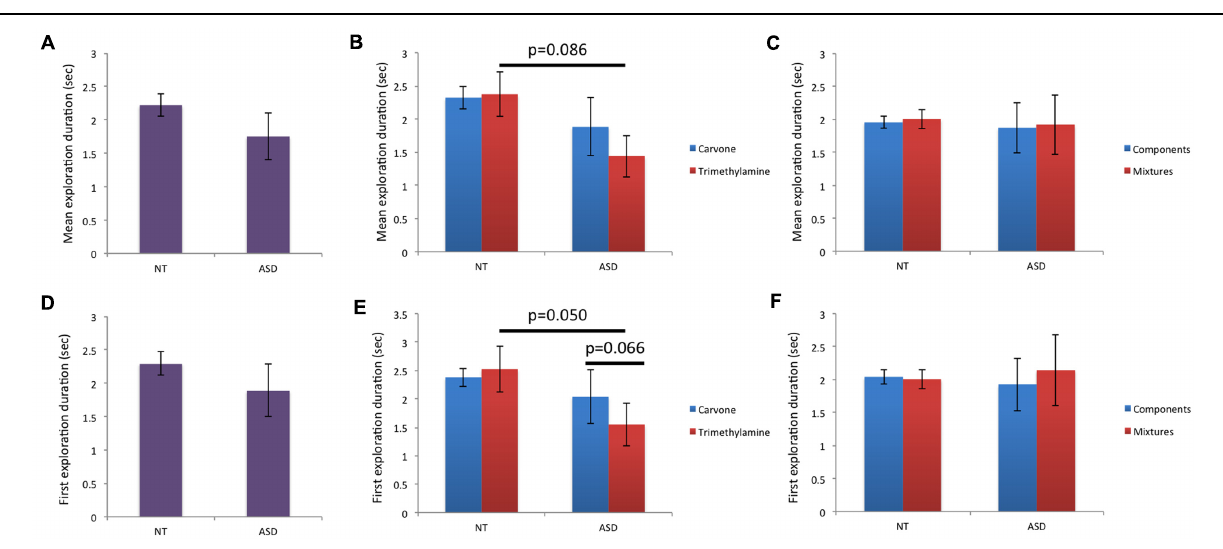
FIGURE 4 | Behavioral data (ii): mean duration of all explorations and duration of first exploration. (A–C) For mean duration of all explorations, a trend toward shorter mean duration for the unpleasant smell (Trimethylamine) in ASD than NT children was found ( p = 0.086). The other inter-group or intra-group comparisons were non-significant. (D–F) For duration of first exploration, a significant effect of group was observed for Trimethylamine: ASD children explored this unpleasant odor less than NT children ( p = 0.050). Moreover, a trend toward shorter exploration duration for Trimethylamine than Carvone was observed in the ASD group ( p =